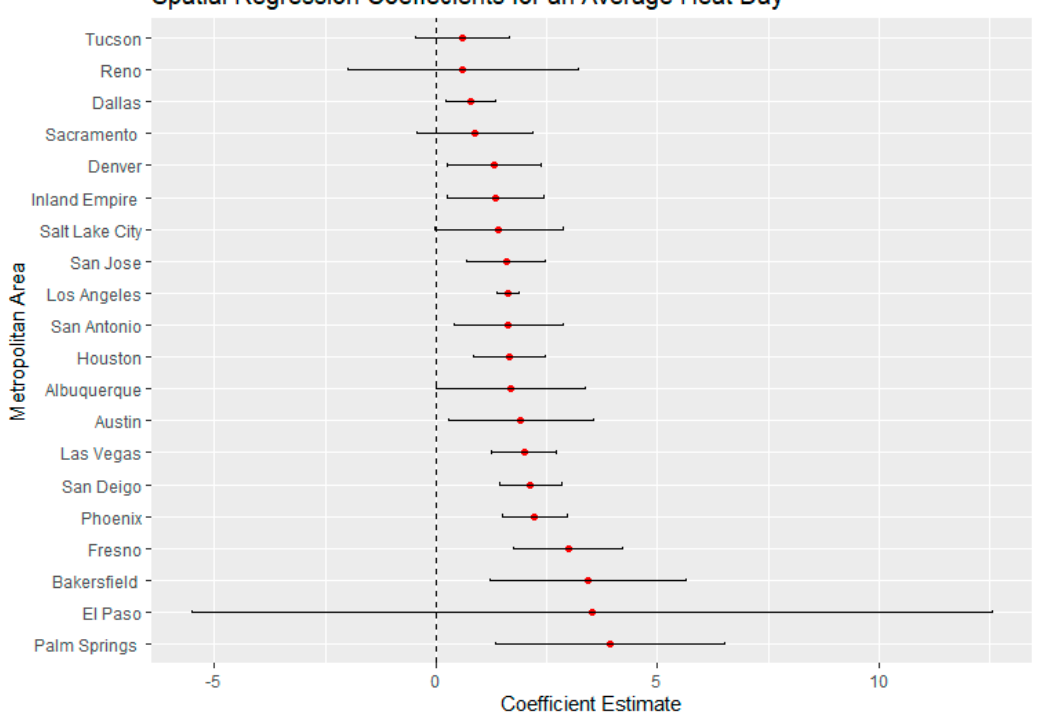
Figure 7. Spatial regression coefficients for Latinx populations during an average heat day in 20 Southwest metropolitan areas.